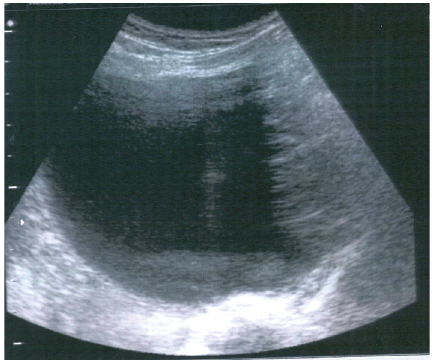
Figure 1: A cyst in the left ovary with mixed echogenicity and irregular inner contents.